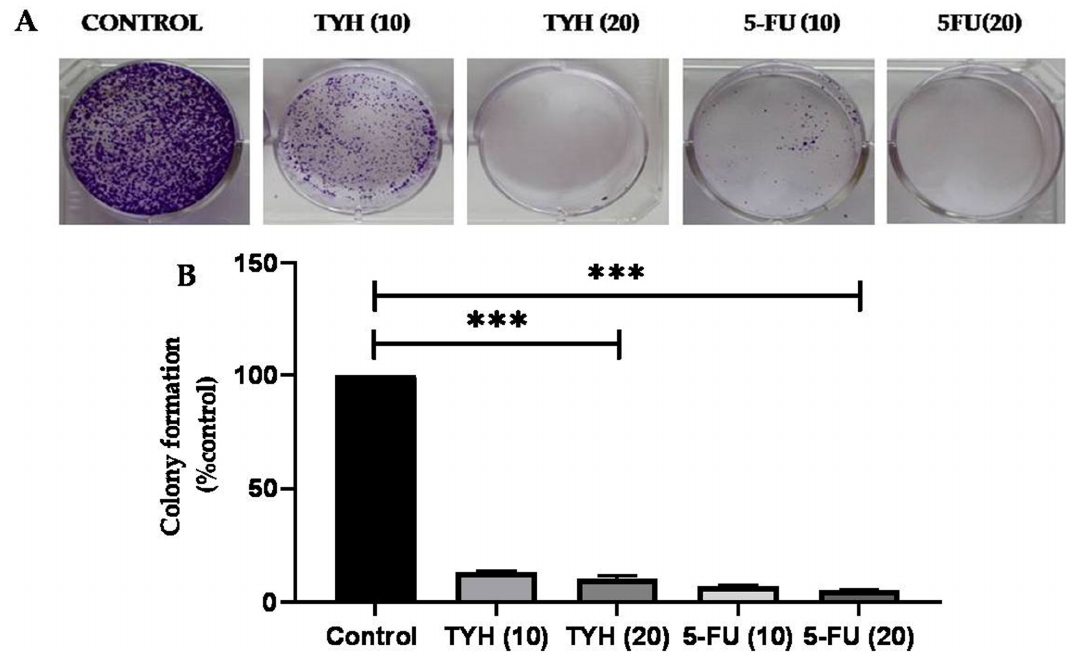
Figure 4. ( A ) Cells’ capacity to form colonies after being exposed to various doses of TYH for 24 h. Crystal violet dye was used to stain cells after they had been fixed with 4% paraformaldehyde, and a colony counter was used to count the number of colonies.( B ) Graph showing % colonies formed after treatment with different concentrations (0, 10, and 20 µg/mL) of TYH for 24 h. The values indicate mean ± SD ( n = 3), *** p < 0.001 vs. control. Graph shows dose-dependent decrease in % colony formation relative to control.